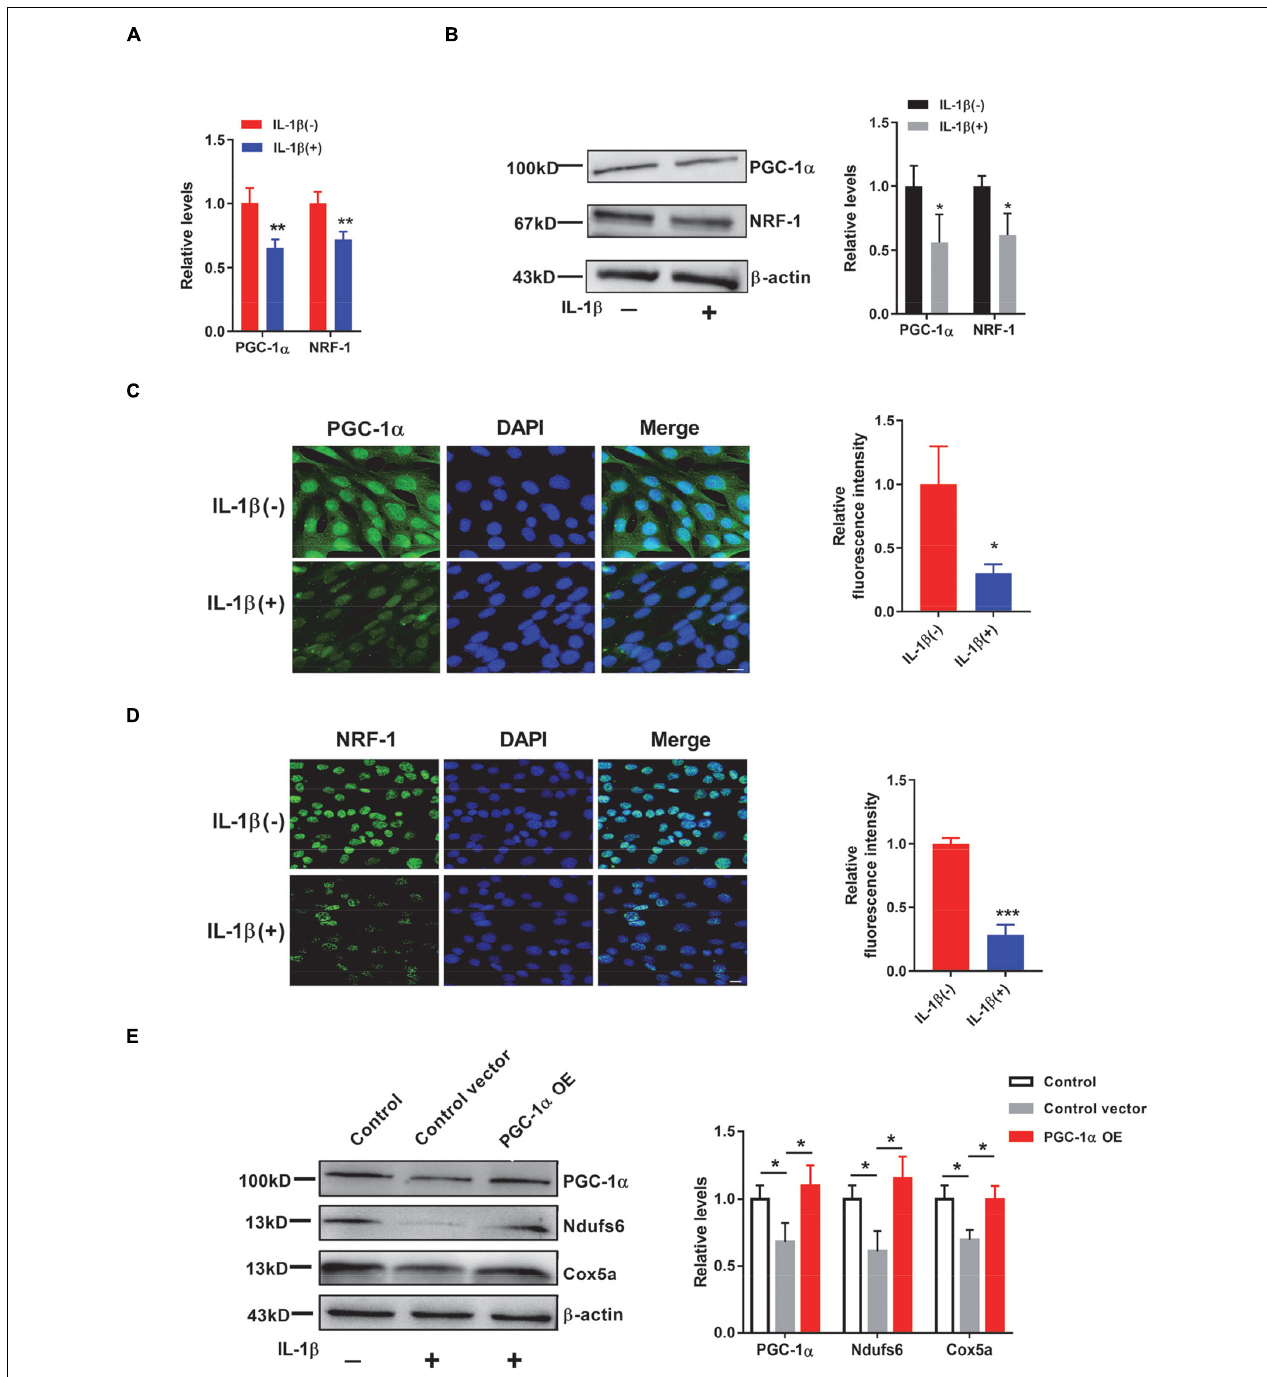
FIGURE 6 | IL-1 β induces reductions in peroxisome proliferator-activated receptor- γ coactivator-1 α (PGC-1 α ) and Nuclear respiratory factor-1 (NRF-1) levels in HT22 cells. (A,B) Levels of PGC-1 α and NRF-1 were determined by quantitative PCR (qPCR) (A) ( n = 4) and by immunoblotting and densiometric analysis (B) in control and IL-1 β -treated HT22 cells ( n = 4 per group). β -actin was included as an input control. (C) Representative images of PGC-1 α (green) and DAPI (blue) in control HT22 cells and HT22 cells treated with IL-1 β . Scale bar: 20 µ m. The relative immunofluorescence intensity of PGC-1 α was plotted in IL-1 β -treated HT22 cells over control HT22 cells ( n = 3 per group). (D) Representative images of NRF-1 (green) and DAPI (blue) in control HT22 cells and HT22 cells treated with IL-1 β . Scale bar: 20 µ m. Relative immunofluorescence intensity of NRF-1 in IL-1 β -treated HT22 cells over control HT22 cells ( n = 3 per group). (E) HT22 cells were transfected with control plasmid (control vector) or PGC-1 α overexpression plasmid (PGC-1 α OE) prior to IL-1 β treatment. Levels of PGC-1 α , Ndufs6, and Cox5a in HT22 cells with (control vector and PGC-1 α OE) or without (control) IL-1 β treatment were determined by immunoblotting and densiometric analysis ( n = 3). β -actin was included as an input control. * P < 0.05; ** P < 0.01; *** P < 0.001 by independent samples Student’s t -test or one-way ANOVA; error bars denote the